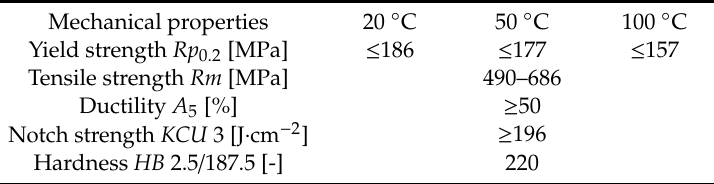
Table 2. Mechanical properties of AISI 304.